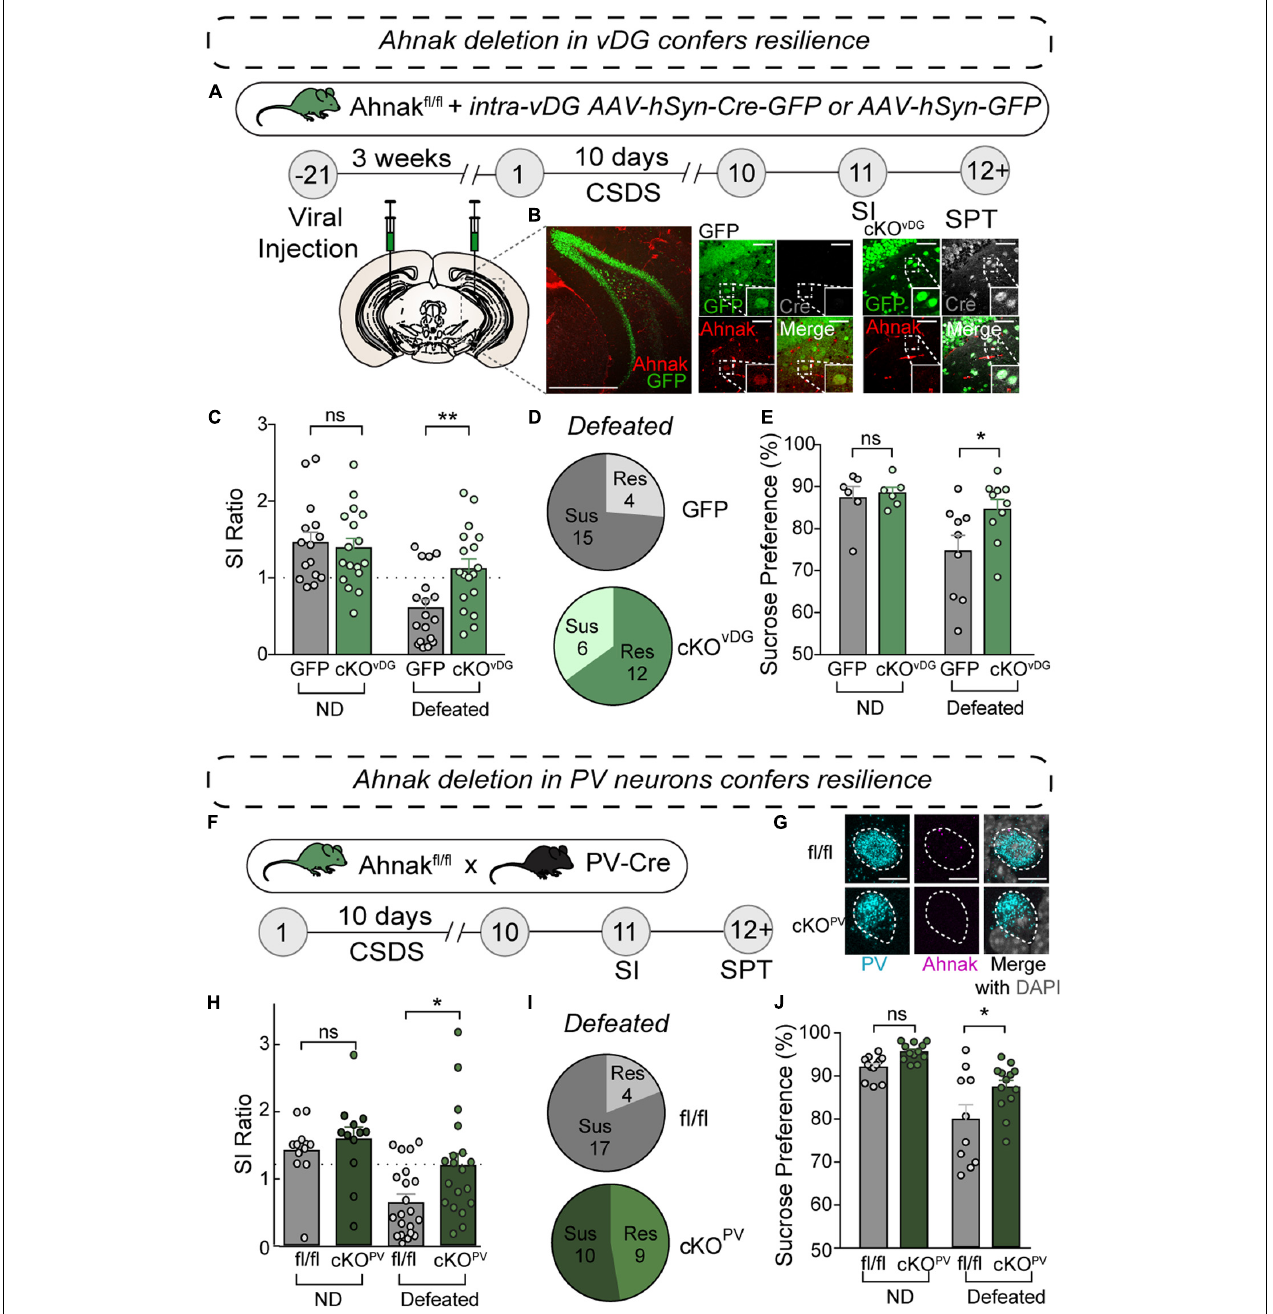
FIGURE 5 | Ahnak deletion in vDG or PV neurons confers resilience to CSDS. (A) Diagram and timeline for conditional knockout approach using stereotaxic AAV injections of AAV-Cre-GFP or AAV-GFP control. (B) Representative confocal image of coronal brain section stained for GFP and Ahnak, depicting deletion of Ahnak selectively in vDG neurons. Scale Bar, 500 µ m (left), 50 µ m (right). (C) Ahnak cKO vDG mice display a higher SI ratio than GFP-controls (Cont) [two-way ANOVA, Non-defeat (ND): Cont ( n = 16) and cKO vDG ( n = 17), Defeated: Cont ( n = 19) and cKO vDG ( n = 18)]. (D) Pie charts showing the number of resilient and susceptible animals resulting after CSDS. (E) Ahnak cKO vDG mice display decreased stress-induced anhedonic-like behavior in the sucrose preference test after CSDS [two-way ANOVA, ND: Cont ( n = 6) and cKO vDG ( n = 6), Defeated: Cont ( n = 9) and cKO vDG ( n = 10)]. (F) Behavioral timeline and diagram of conditional knockout approach for Ahnak cKO PV . (G) Confocal images showing absence of Ahnak mRNA in PV vDG neurons in mice with a conditional deletion in PV neurons (cKO PV ). (H) After CSDS, cKO PV mice display a higher SI ratio compared to control mice (fl/fl) [two-way ANOVA, ND: fl/fl ( n = 12) and cKO PV ( n = 12), Defeated: fl/fl ( n = 21) and cKO PV ( n = 19)]. (I) Pie charts showing the number of resilient and susceptible animals resulting after CSDS. (J) Ahnak cKO PV mice display increased sucrose preference after CSDS compared to controls [two-way ANOVA, ND: fl/fl ( n = 12) and cKO PV ( n = 12), Defeated: fl/fl ( n = 10) and cKO PV ( n = 13)]. Data are expressed as mean ± SEM and individual data points are depicted. Post hoc Bonferroni’s multiple comparisons were used for ANOVA. * p < 0.05, ** p < 0.01 and ns, non-significant.